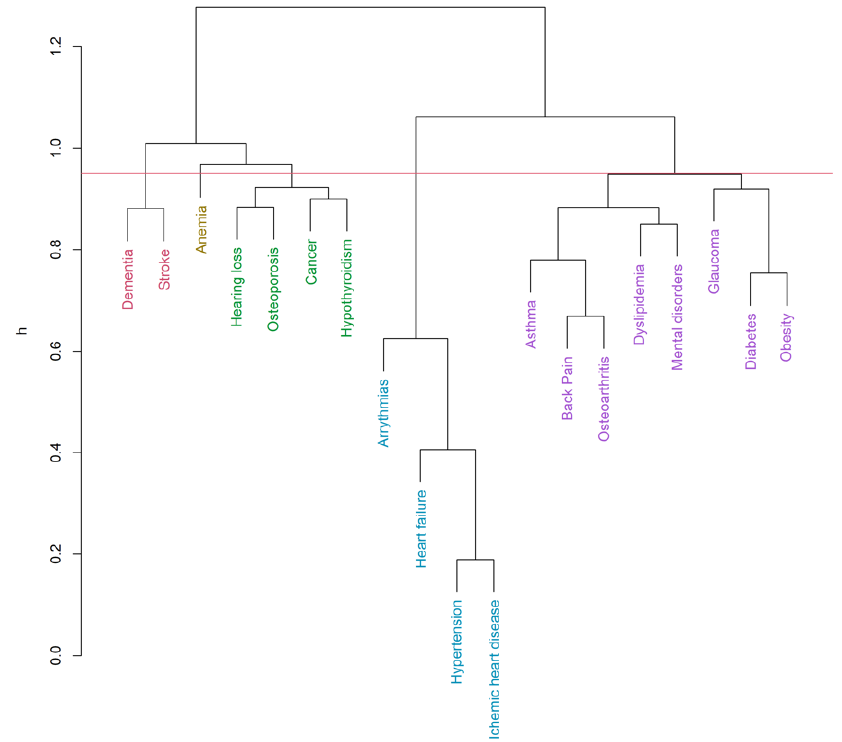
Figure 2. Clusters of comorbidities (COPD group—female, Ward’s method, h = 0.95, average Silhou- ette width = 0.06, Dunn index = 0.64).